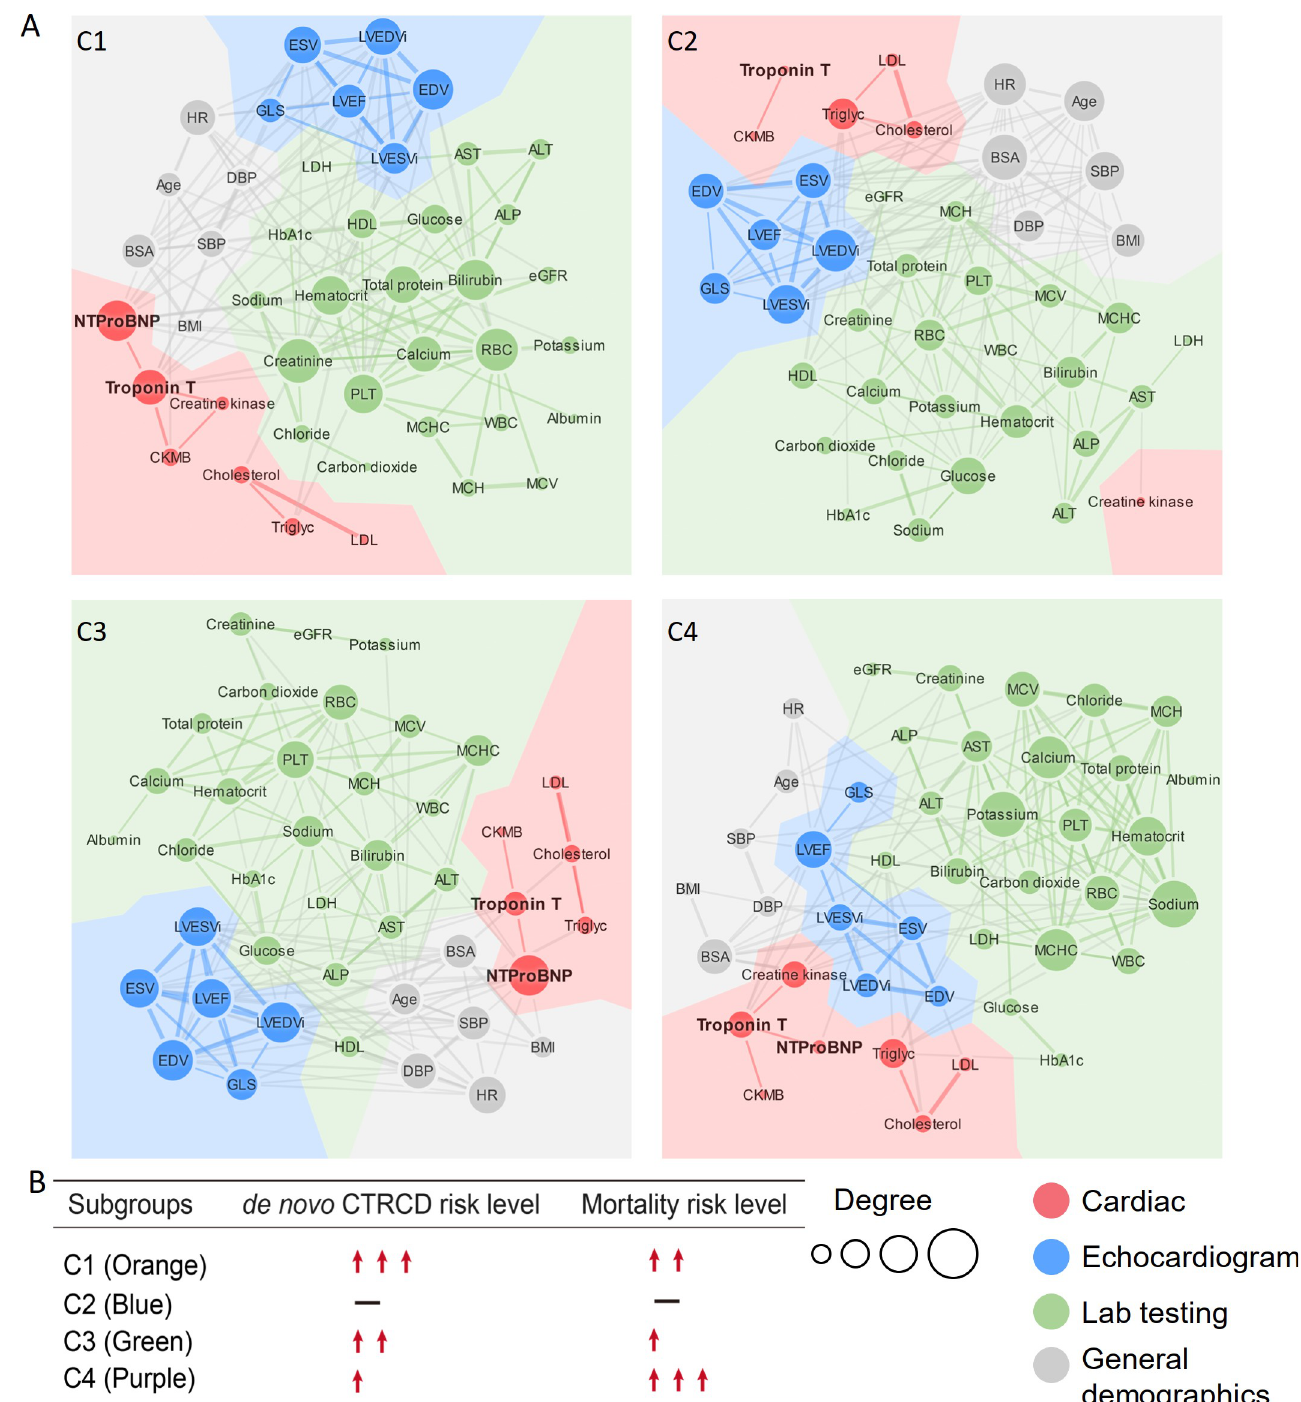
Fig 4. Clinical variable networks across 4 patient clusters. (A) Clinical variable–variable networks across 4 patient subgroups: Orange subgroup: C1, intermediate survival and the highest de novo CTRCD risk; blue subgroup: best survival and the lowest de novo CTRCD risk; green subgroup: intermediate survival and intermediate de novo CTRCD risk; purple subgroup: the worst survival and intermediate de novo CTRCD risk. Top 15% of PCC value was used for the final cutoff for each network. At this cutoff, the highest p -value among all the correlations in all clusters was p = 0.008 (see Methods). Variables were colored by 4 categories of clinical variables: cardiac (red), echocardiogram (blue), lab testing (green), and general demographics (gray). Size of node indicates the degree (connectivity). Size of edges indicates the PCC value in the clinical variable network. ( B) De novo CTRCD and mortality risk are presented for each subgroup. The abbreviations for all variables are provided in S1 Table . CTRCD, cancer therapy–related cardiac dysfunction; NT-proBNP, NT-proB-type Natriuretic Peptide; PCC, Pearson correlation coefficient.